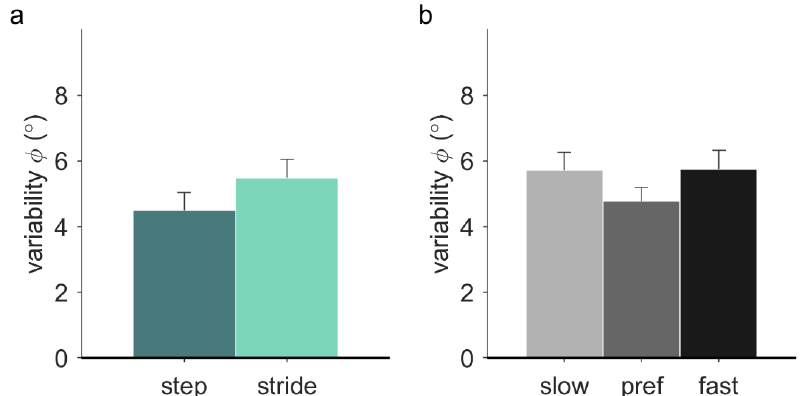
Figure 4. Variability of the relative phase ( ϕ ) during stationary auditory-motor coordination. ( a ) The different pacing types ( N = 13) ( b ) The different pacing frequencies ( N = 11). Error bars represent the standard error of the mean.